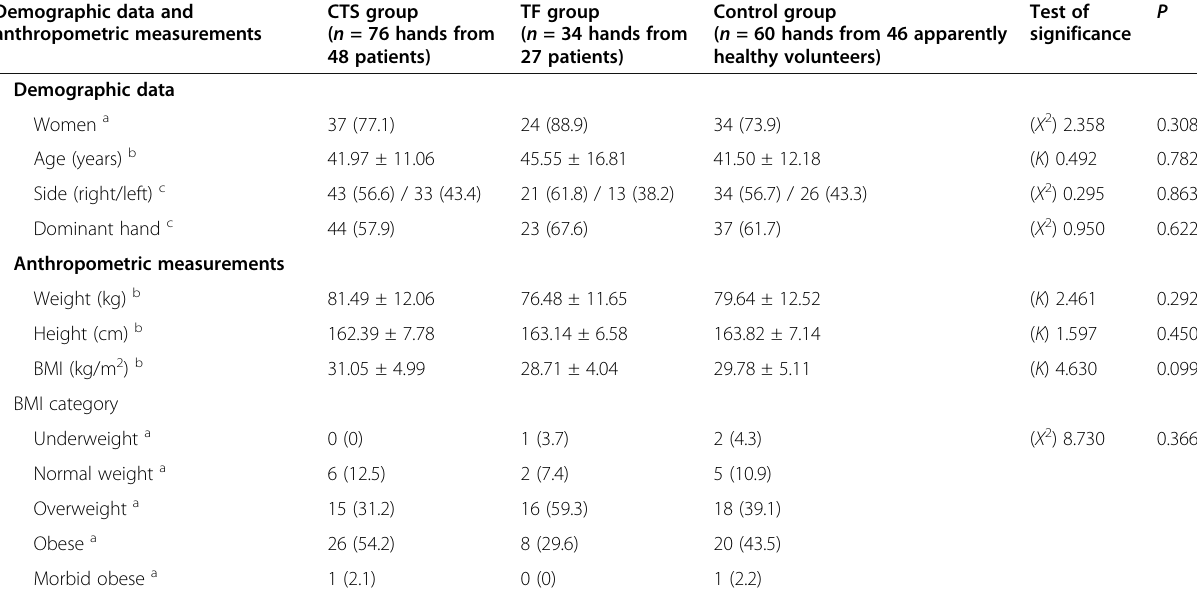
Table 1 Comparison between the two patients ’ groups and the control group regarding demographic data and anthropometric measurements